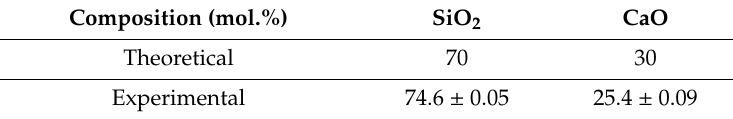
Figure 2. XRD patterns of glass samples heated at 700, 800, 900 and 1000 °C. Table 1. The composition of bioactive glass 70SiO 2 ‐ 30CaO.